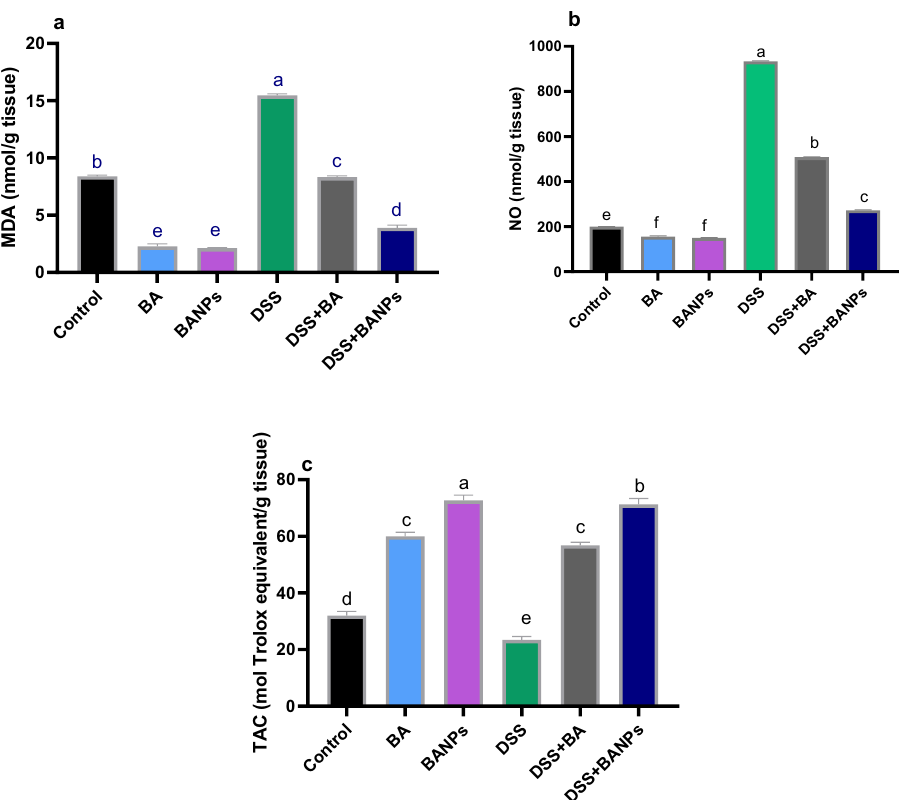
Figure 4. Effects of orally administered B. amyloliquefaciens (BA) or BA-nanoparticles (BANPs) in non- colitic and colitic rats on lipid peroxides expressed as malondialdehyde; MDA. ( a ) Nitric oxide; NO. ( b ) Total antioxidant capacity; TAC ( c ) 7 days post DSS induction. Non-colitic groups including Control, BA and BANPs groups where rats were orally gavaged PBS, B. amyloliquefaciens and B. amyloliquefaciens loaded nanoparticles (BA at level of 1.0 × 10 10 CFU/kg in 1 mL of PBS/rat/day), respectively, for 7 days. Colitic groups: DSS, BA and BANPs groups where rats were orally gavaged dextrane sodium sulphate (DSS), B. amyloliquefaciens + DSS and B. amyloliquefaciens loaded nanoparticles (BA at level of 1.0 × 10 10 CFU/kg in 1 mL of PBS/rat/day) + DSS , respectively, for 7 days. All groups orally gavaged by 5% DSS. Values are expressed as mean ± SE, a,b,c Means of the bars with different letters were significantly different among groups ( P <